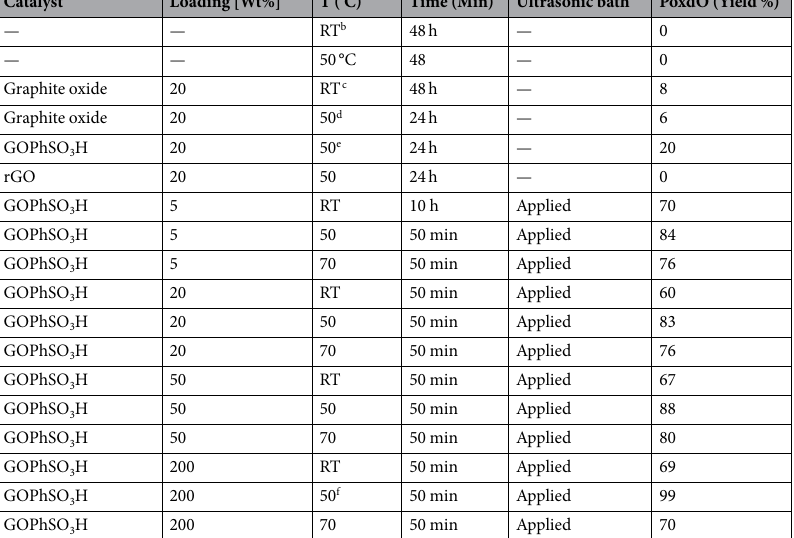
Table 1. Investigation of several reaction conditions for the cyclization of 4-methyl benzohydrazide with carbondioxide into 5-phenyl-3H-[1, 3, 4]-oxadiazol-2-one (PoxdO) a . (See Table S1 for further optimization studies). a Reaction conditions: 4-methyl benzo hydrazide (1 mmol), carbon dioxide (1 atmospheric pressure), GOPhSO 3 H (200 wt%). b blank experiment at room temperature without graphite materials and ultrasonic bath, c,d Trial experiments with graphite oxide at RT and 50 °C respectively in the absence of ultrasonic irradiation, e Experiment carried with sulfonated graphite oxide, under ultrasonic bath, f Successful reaction carried out using GOPhSO 3 H under